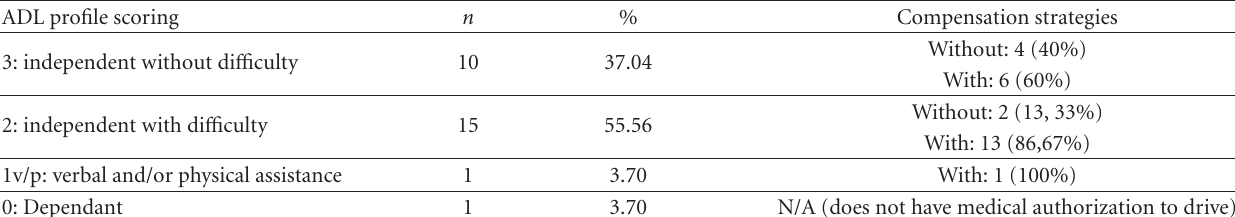
Table 6: Perceived level of independence of participants for driving and the use of compensation strategies. ADL profile